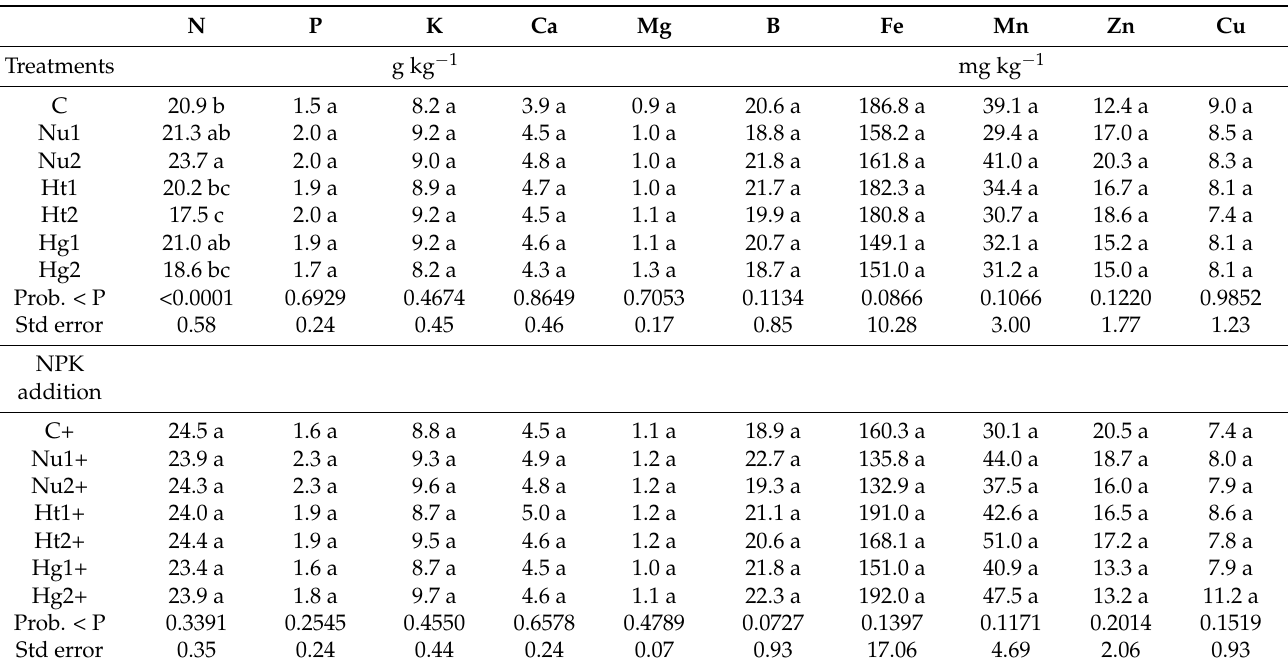
Table 2. Leaf nutrient concentration in response to the application of organic amendments (C, Control; Nu, Nutrimais; Ht, Humitec; and Hg, Humic gold, applied at two rates (1,2)) in the experiments without and with NPK(+) mineral fertilization. For each independent experiment, means followed by the same letter are not significantly different by Tukey HSD test ( α = 0.05).